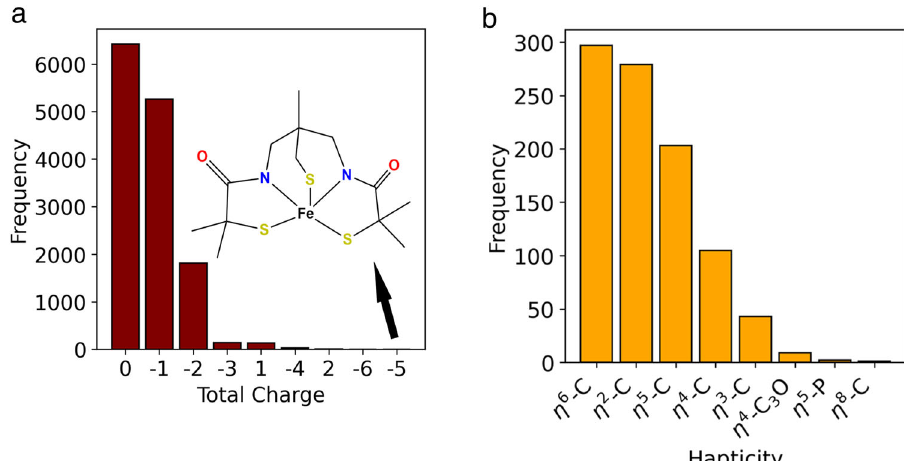
Fig. 5 Chemical diversity in the ligands database. Distribution of (left) total charges and (right) hapticity modes in the database of 13,819 unique ligands. The inset shows the single case of a ligand with − 5 charge, in QORFAG.